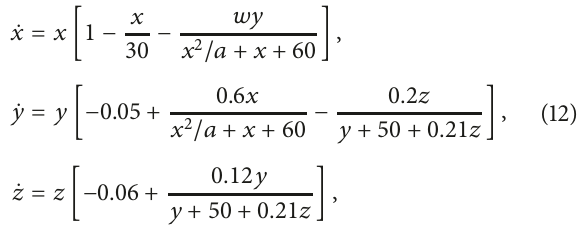
Figure 5 is obtained by using the current method. (𝑎) is time series plot and (𝑑) is the three-dimensional space graph with 𝑎 = 7 ; (𝑏) is time series plot and (𝑒) is the three- dimensional space graph with 𝑎 = 9 ; (𝑐) is time series plot and (𝑓) is the three-dimensional space graph with 𝑎 = 12 . We can see that, from the figure, the fluctuation range of 𝑥, 𝑦, 𝑧 at 𝑡 = 900 is very large when 𝑎 = 7 ; the fluctuation range of 𝑥, 𝑦, 𝑧 at 𝑡 = 900 is obviously reduced when 𝑎 = 9 ; 𝑥, 𝑦, 𝑧 at 𝑡 = 900 almost all tend to be stationary when 𝑎 = 12